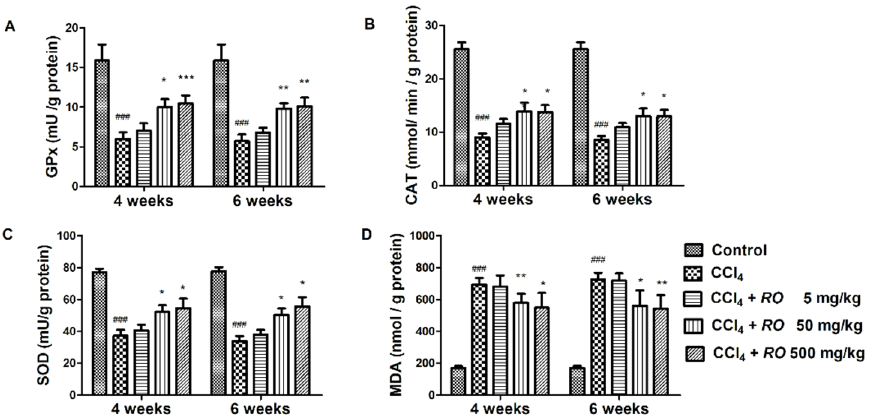
Figure 3. Effects of R. officinalis tincture on: glutathione peroxidase (GPx) ( A ); catalase (CAT) ( B ); superoxide dismutase (SOD) ( C ); and malondialdehyde (MDA) ( D ) (mean ± SD, 5 animals/group). ### p < 0.001, compared to the Control group; * p < 0.05, ** p < 0.01 and *** p < 0.001 compared to the CCl 4 alone treated group.